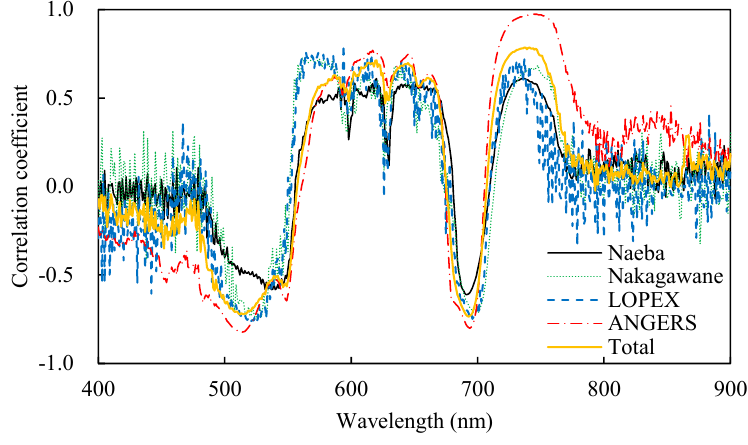
Figure 10. Correlations between first-order derivative spectra and chlorophyll content.